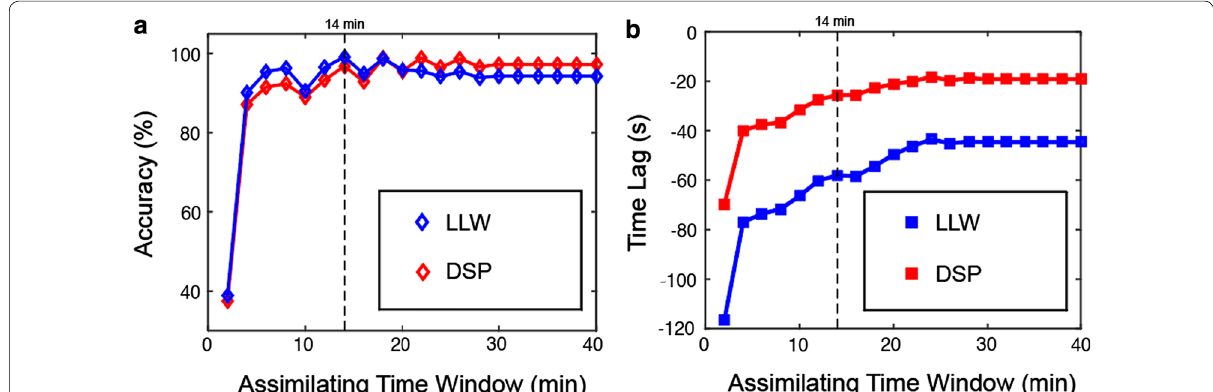
Fig. 4 Forecast accuracy a and time lag b of the two models for various assimilation time windows. The forecast accuracy is used to evaluate the forecasted maximum amplitude of the first tsunami peak (Aida 1978). The time lag is used to examine the forecasted arrival time (Tsushima et al.